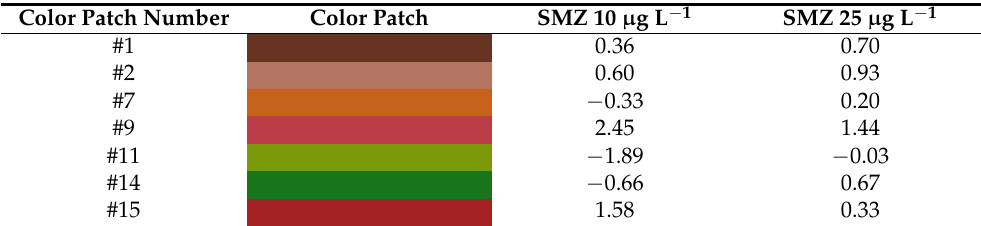
Figure 3. Relation between color and SMZ concentration in the range of 0 to 150 µg L − 1 using the coordinates from the color spaces RGB (Red, Green, Blue), HSV (Hue, Saturation, Value) and CIELAB (Lightness, a_star, b_star). Table 1. Values (Student’s t -test) for the color patches that provided no significantly different reading under various illumination conditions ( t tab = 2.78, α = 0.05).